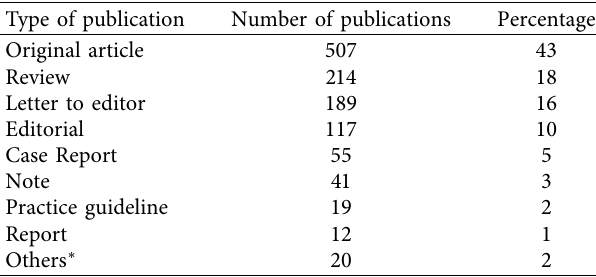
Table 3: The distribution of ophthalmology-focused articles by their publication